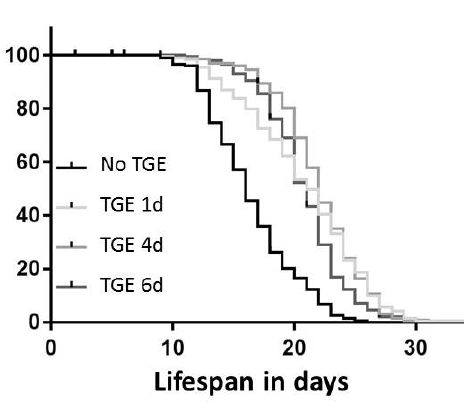
Figure 4. Survival rate of C. elegans after one, four, and six days of TGE.